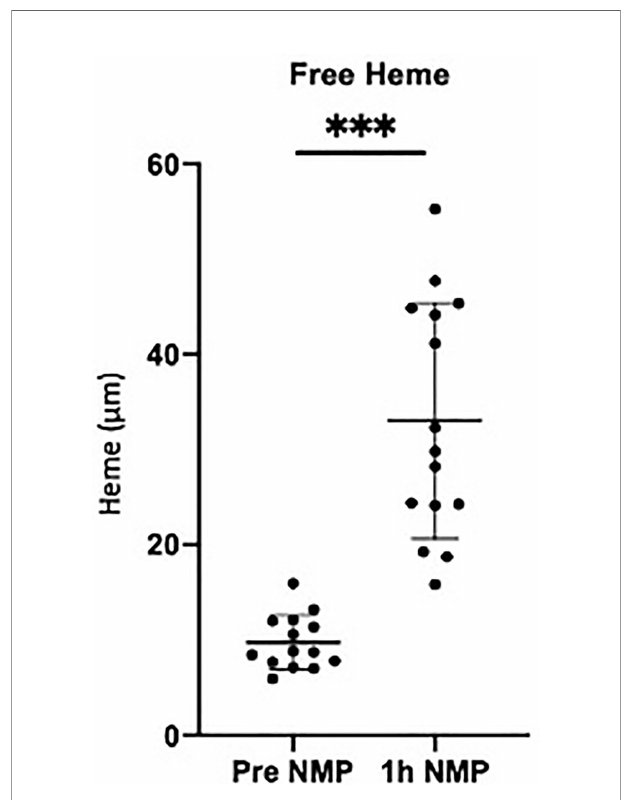
FIGURE 2 | Levels of free heme measured in the perfusate pretransplant and post 1h NMP in a series of human kidneys that were rejected for transplanted and offered for research. Data presented as mean (SD). ***P <